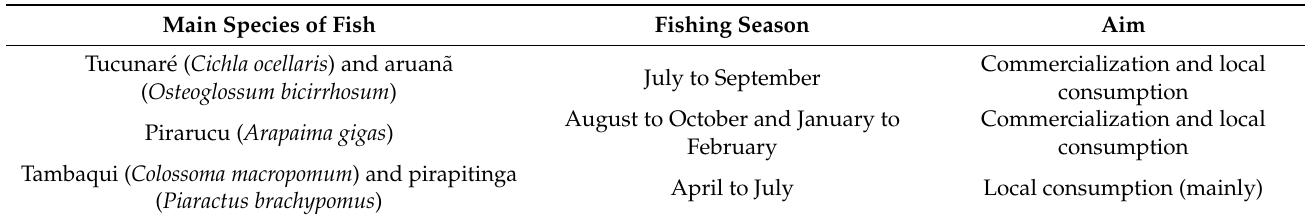
Table 1. Key technical information used to support the formulation of the fishing agreement of the communities of the Coati and Cupari